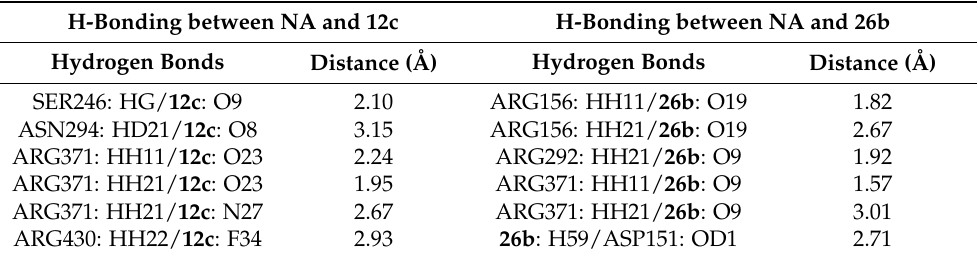
Table 4. Hydrogen bonding interactions between NA (PDB: 2HU0) and compounds 12c and 26b . H-Bonding between NA and 12c H-Bonding between NA and 26b Hydrogen Bonds Distance